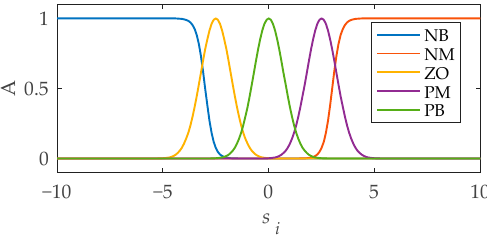
Figure 6. Membership functions of s i .